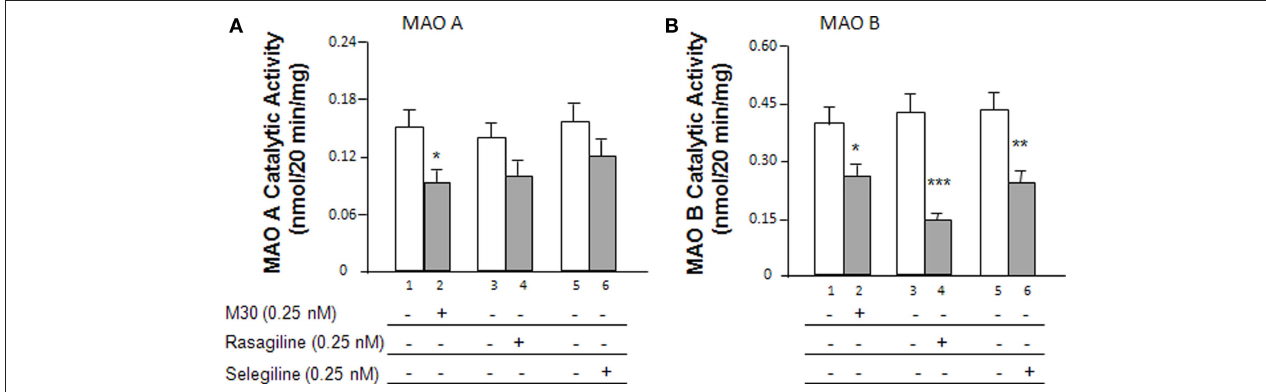
Figure 1 | effects of the MAO inhibitors, M30, rasagiline and selegiline, on MAO catalytic activity in SH-SY5Y cells. (A) Cells were treated with the MAO inhibitors (0.25 nM) for 72 h and the MAO A catalytic activities were determined. (B) Cells were treated with the MAO inhibitors (0.25 nM) for 72 h and the MAO B catalytic activities were determined. * P < 0.05, ** P < 0.01, and *** P < 0.002 compared to untreated controls,